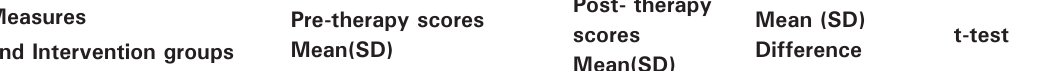
Table 4. Pre and Post-therapy assessment scores of ATQ-R among intervention groups. Measures and Intervention